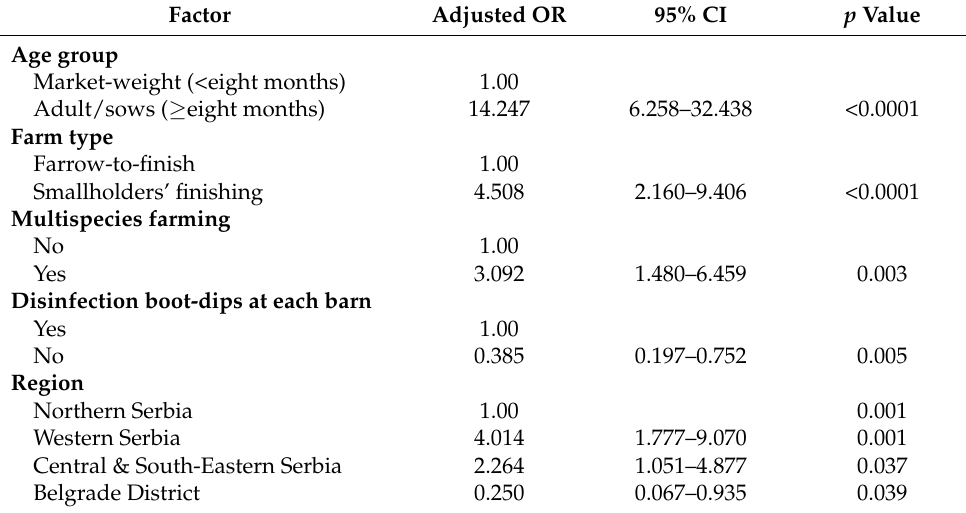
Table 3. Risk factors for Toxoplasma gondii infection in pigs (N = 581, with complete biosecurity questionnaires only) in Serbia. Final multivariate model; individual pigs as units of